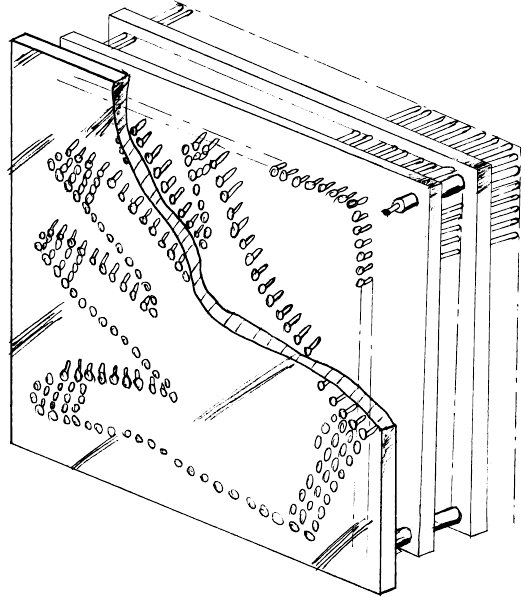
Figure 1. Schematic drawing of 3D pin art (based on the work in [2]).